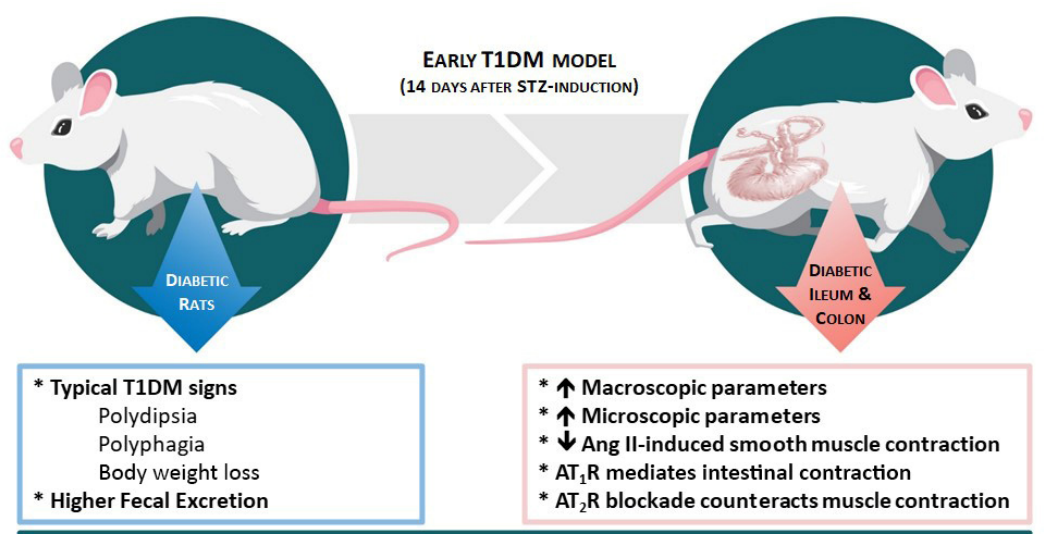
Figure 9. Schematic representation of the major findings observed in this early T1DM model. Diabetic rats showed typical DM signs ( left part of the scheme). The ileum and colon revealed an increase in both macro/microscopic parameters and a decrease in Ang II-induced smooth muscles contraction, mediated by both AT 1 R and AT 2 R activation ( right part of the scheme). Supplementary Materials: The supporting information can be downloaded